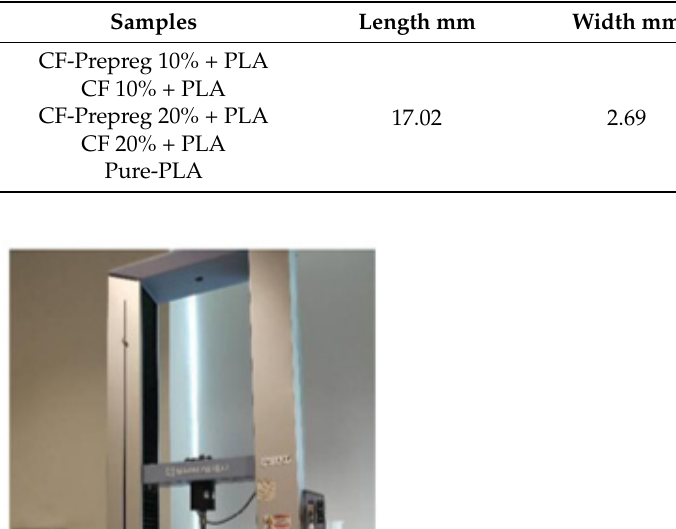
Figure 11. Tensile testing machine with a sample. Table 1. Dimensions of the prepared tensile test specimens.